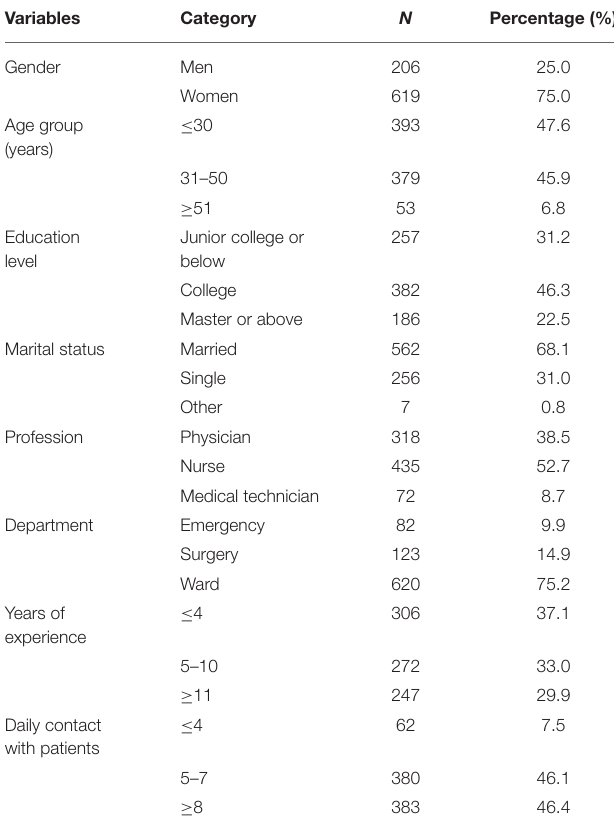
TABLE 1 | Demographic characteristics of the whole sample ( N =